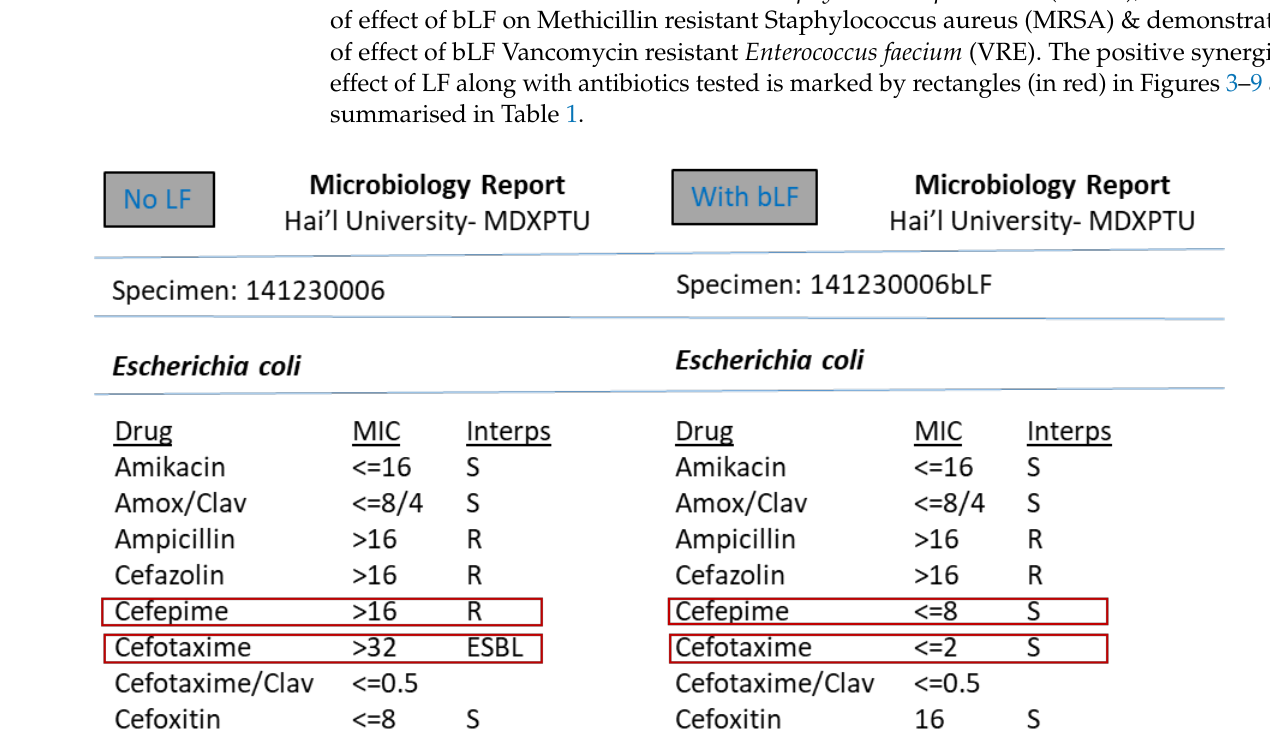
Figure 3. Demonstration of effect of bovine lactoferrin (bLF) on extended spectrum β-lactamase (ESBL) producing clinical Escherichia coli .